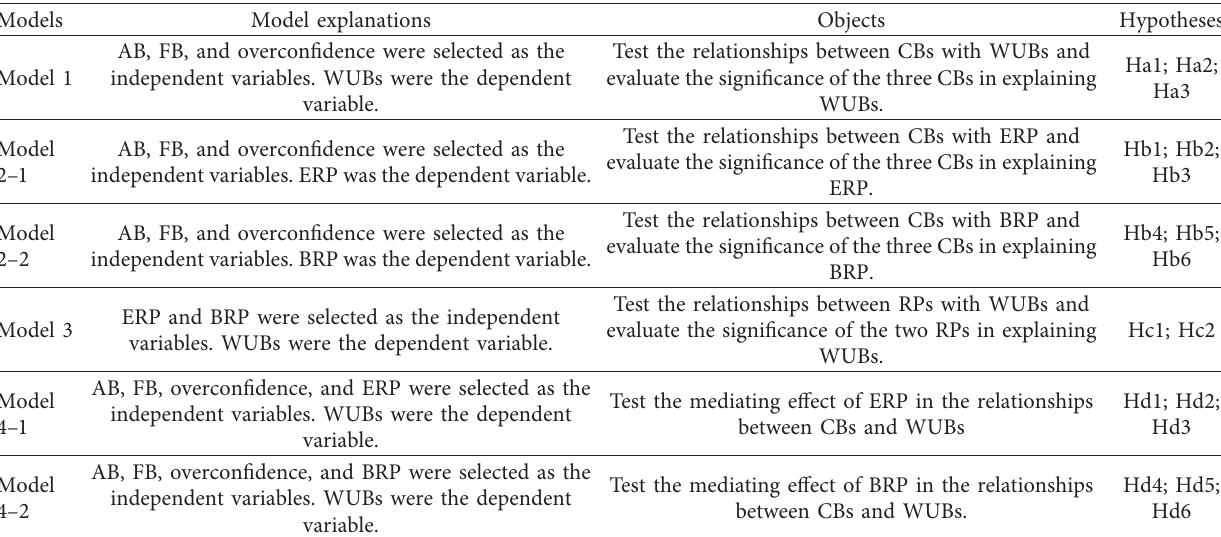
Table 3: The six models and their explanation.